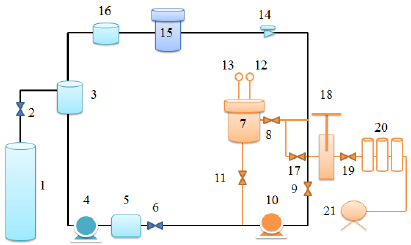
Figure 2. Schematic diagram of the supercritical system for diacetate fiber impregnation: (1) CO 2 cylinder, (2, 6, 8, 9, 11, 17, 19) Valves, (3) Cooler, (4) Liquid pump, (5) Pre-heater, (7) Impregnation unit, (10) Circulation pump, (12) Pressure transducer, (13) Thermometer, (14) Micrometering valve, (15) Separator, (16) Cleaner, (18) Sampling tube, (20) Collecting units, (21) Gas flowmeter [18].